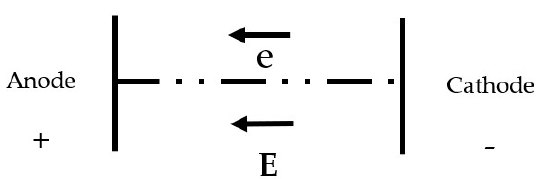
Figure 12. Schematic representation of the charge density distribution in a continuous field that represents the macroscopic dipole in the Coelho model, where e is the circulation of electrons and E electric field.